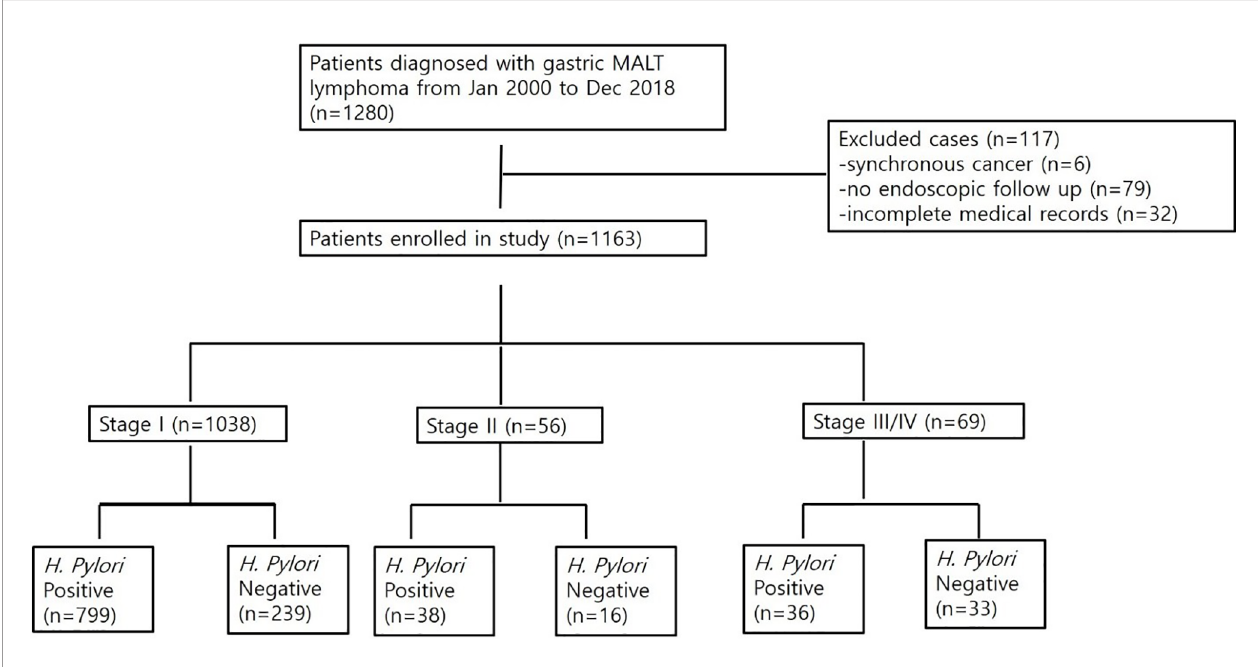
FIGURE 1 | Flow chart of patients included in the study.